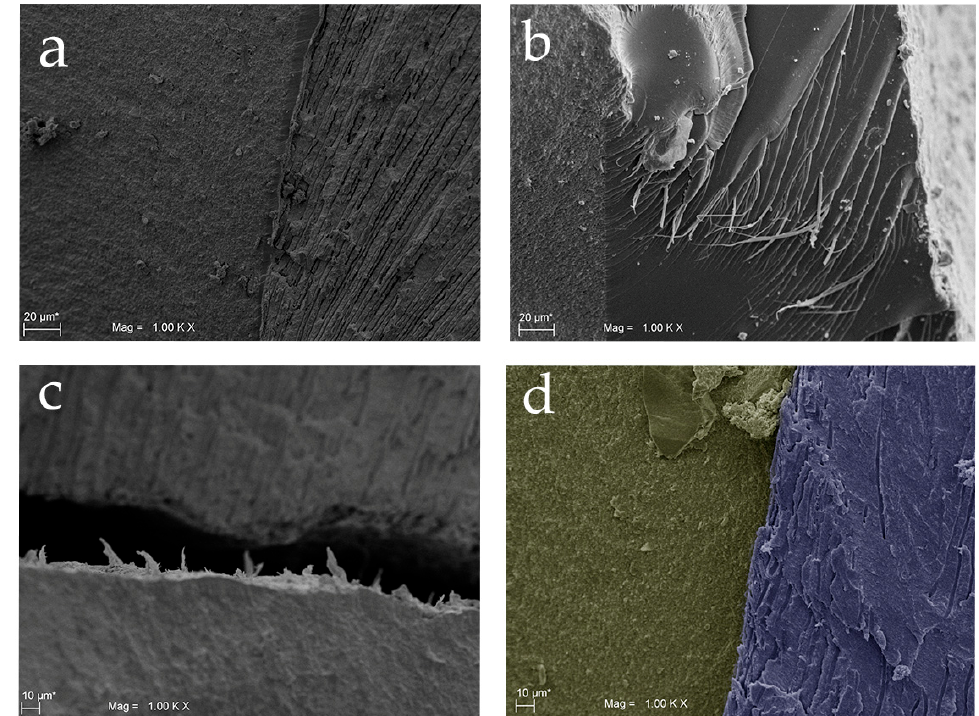
Figure 5. Scanning electron microscope images: ( a ) of Group 1 at 1.00K × magnification. At the interface there are no detachments; ( b ) SEM image of adhesive part, in detail observe the Hackle lines; ( c ) SEM image of Group 2 at 1.00K × magnification; it is shown a clear failure at the interface between dentin and adhesive; ( d ) 1.00K × magnification of both composite and dentin sides.